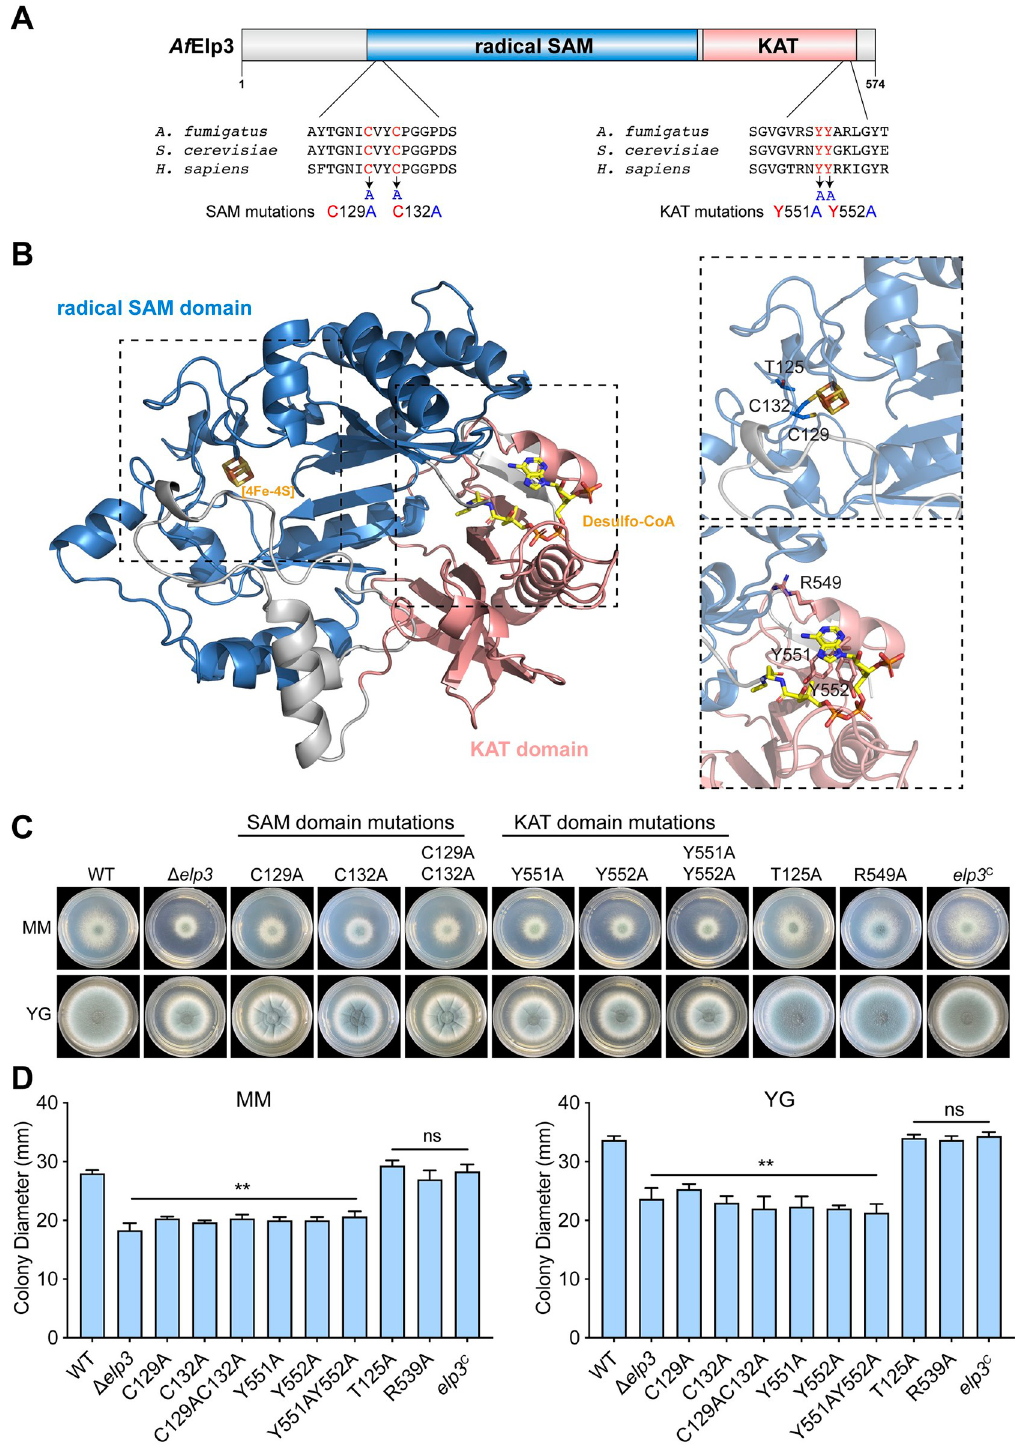
Fig 5. The conserved residues in the rSAM and KAT domains of Elp3 are required for hyphal growth and conidiation in A . fumigatus . (A) Schematic diagram of the A . fumigatus Elp3 protein. The blue box represents the radical-S-adenosyl methionine (rSAM) domain, and the pink box indicates the lysine acetyltransferase (KAT) domain. Cys129 and 132 were substituted with alanine, and Tyr551 and 552 were replaced by alanine. (B) Predicted crystal structure of A . fumigatus Elp3 bound to the [4Fe4S] cluster and desulfo-CoA. The rSAM and KAT domains are shown as blue and pink ribbons,